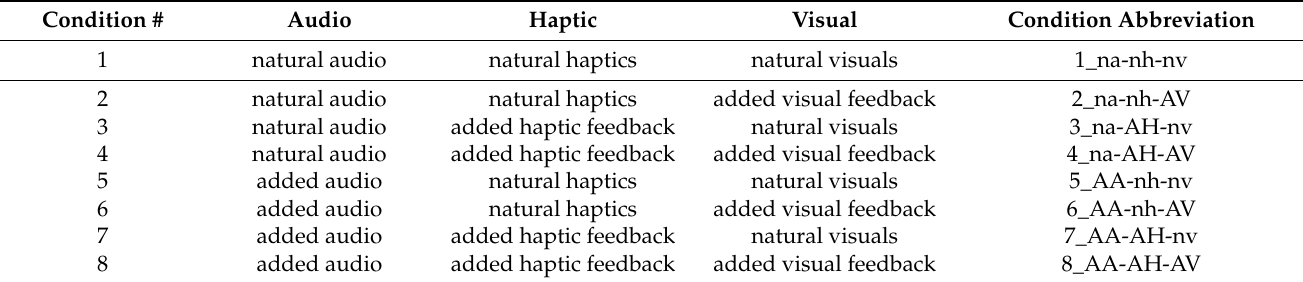
Table 1. The eight conditions experimented with in the